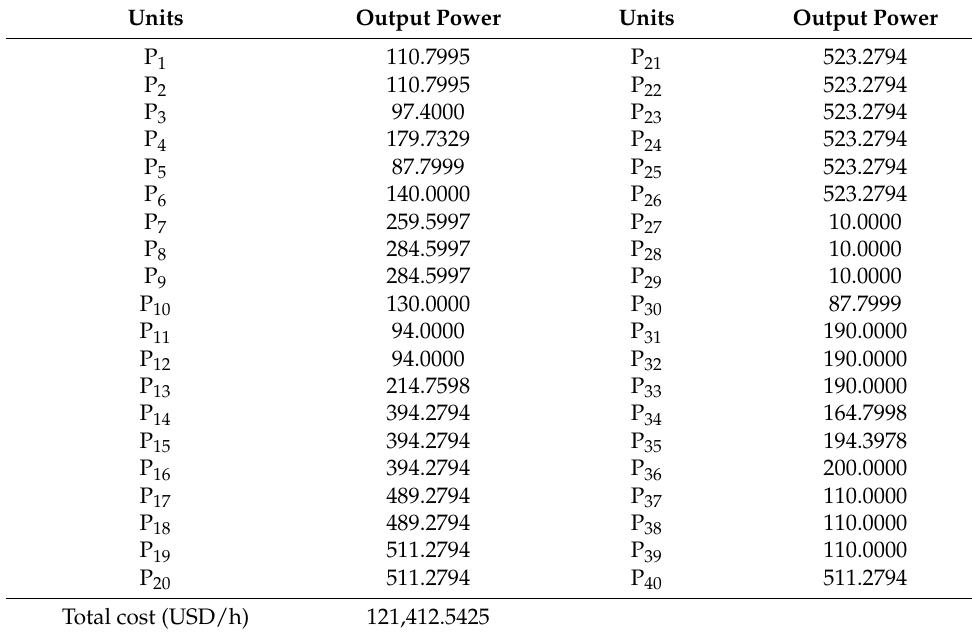
Table 11. The best decision variables obtained by G-SCNHGWO algorithm in Case C.